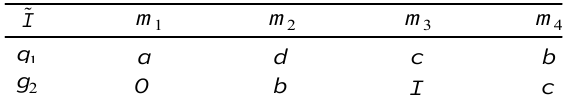
Table 4 ． A lattice-valued formal